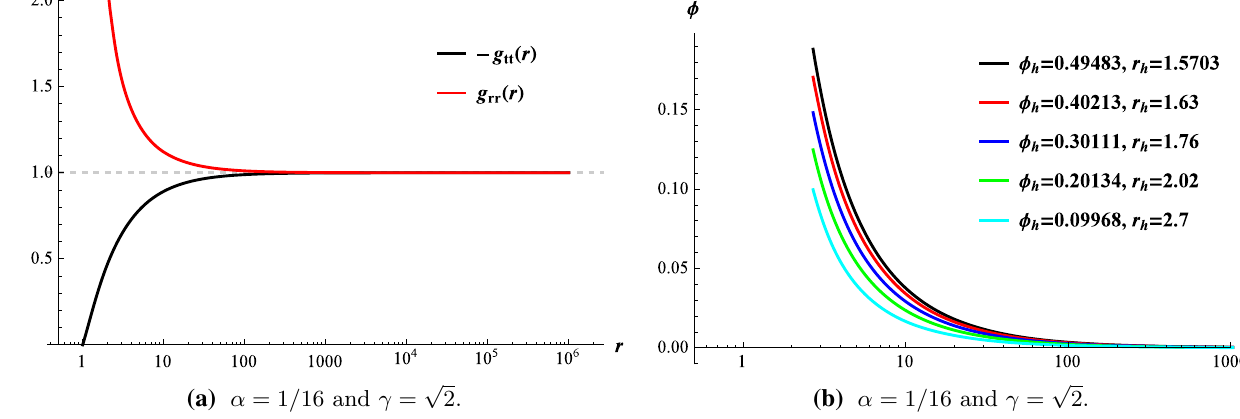
( a ) α = 1 / 16 and γ = Fig. 2 The metric components and φ( r ) of the dilatonic black